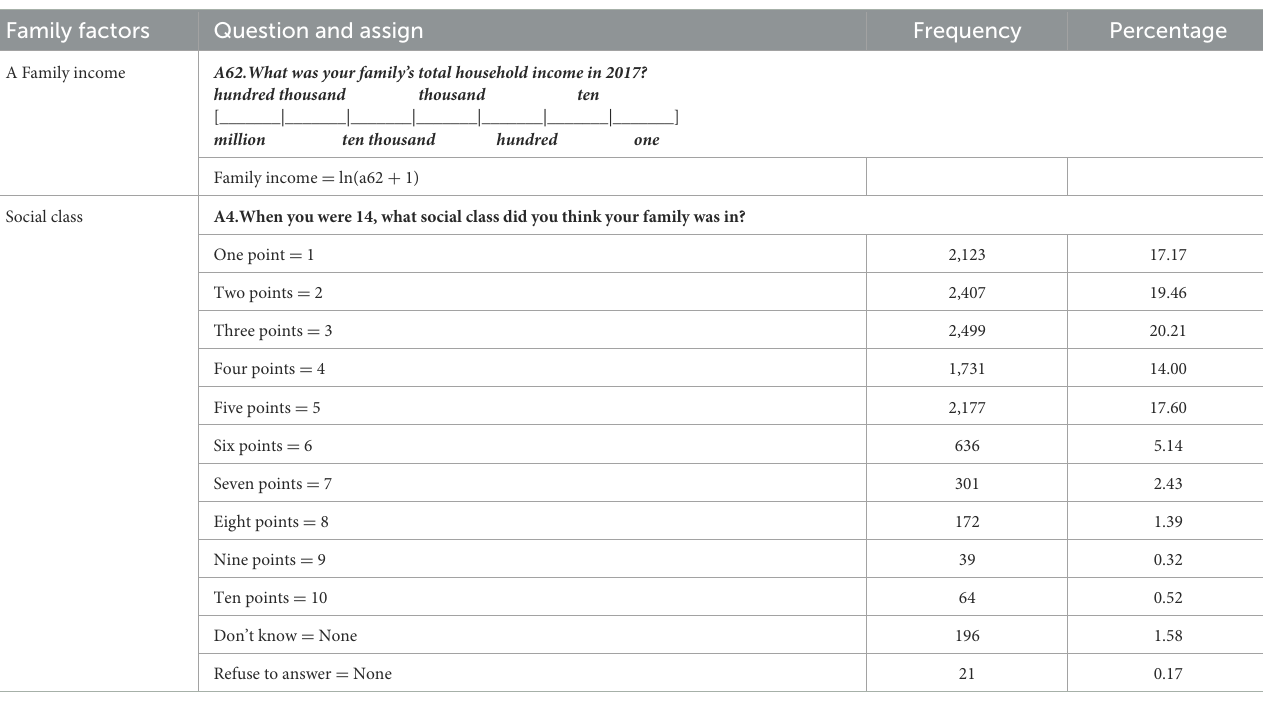
TABLE 3 The measurement of the independent variable—family factors (CGSS 2018). Family